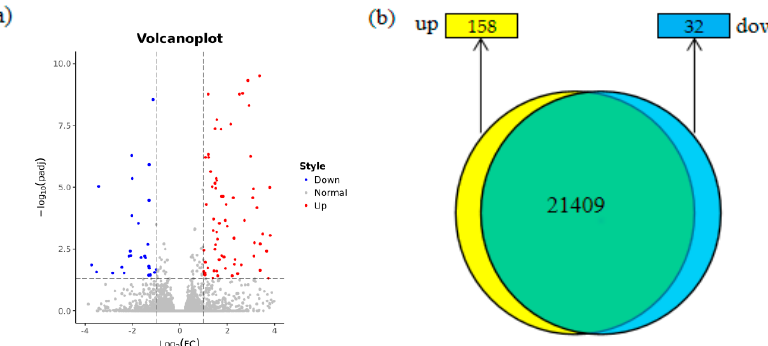
Figure 5. Di ff erentially expressed genes in transgenic lines expressing PITG_15718.2 compared with the wild type. ( a ) Volcano plot showing fold change and adjusted p -value of normalized read counts of the RNA-Seq data. The criteria of log 2 | (fold change) | ≥ 1 and padj ≤ 0.05 were used to identify the di ff erentially expressed genes (DEGs). Blue dots indicate the downregulated DEGs (32 genes), and red dots indicate the upregulated DEGs (158 genes); ( b ) Venn diagram showing the overlap of the DEGs between the transgenic and wild type groups. The sum of all the numbers in the figure represents the total number of genes in the comparison. The overlapping region indicates the number of genes that were not significantly di ff erent between the groups. The yellow label indicates the number of upregulated DEGs and the cyan label indicates the number of downregulated DEGs according the set thresholds.